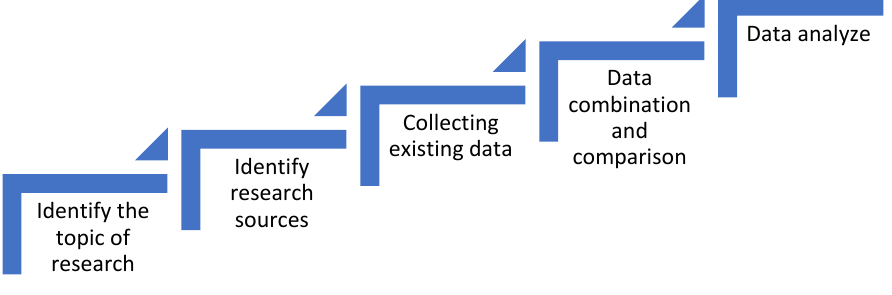
Figure 1. Desk research method